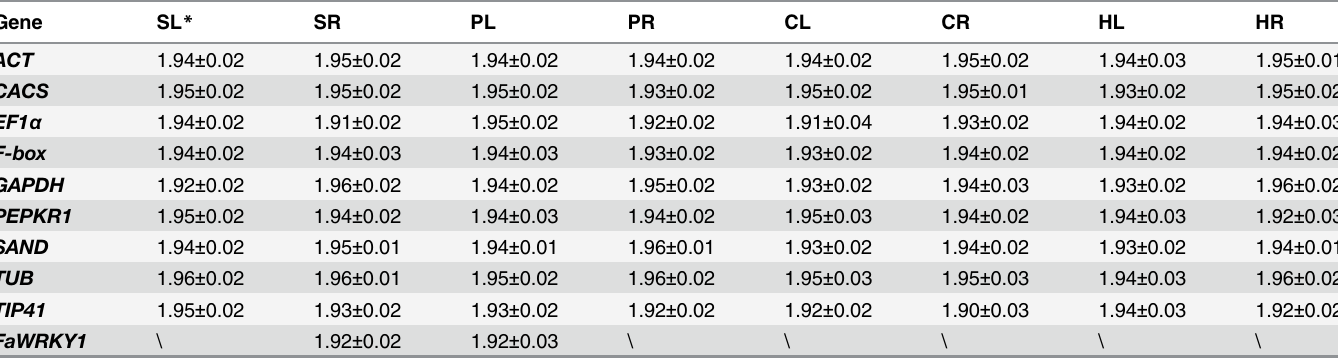
* SR and SL: salt-treated roots and leaves, respectively; PR and PL: PEG-treated roots and leaves, respectively; CR and CL: cold-treated roots and leaves, respectively; HR and HL: heat-treated roots and leaves, respectively.